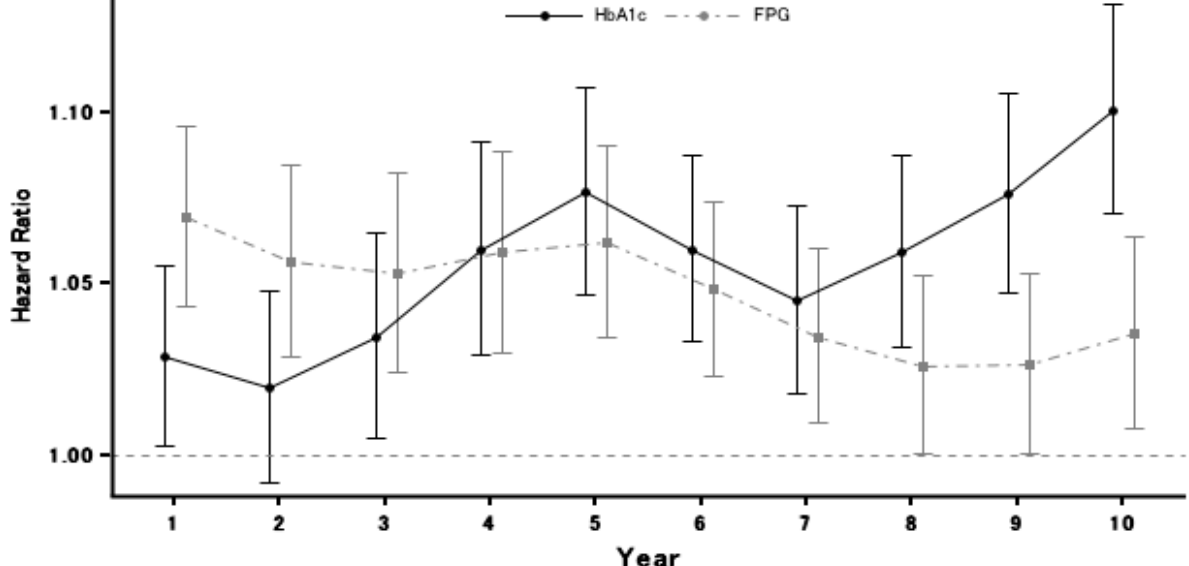
Figure 2. Hazard ratios a for incident type 2 diabetic mellitus by diagnostic test and time window. Note: measurement of PM 2.5 started in 2000, but the beginning of our study period was 2005; as we used a moving average over six years, we therefore restricted our outcome dataset to time points in 2006 and later.